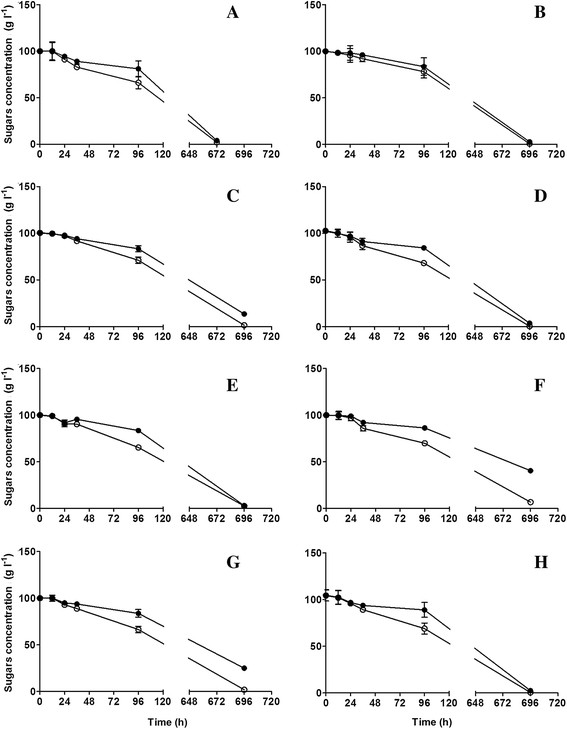
Glucose (○) and fructose (●) consumption profiles compared for the 8 yeast strains QA23 (A), VL1 (B), CEG (C), BRL97 (D), XL (E), T73 (F), NT116 (G) and UCD522 (H) in the media supplemented with low nitrogen (67 mg l
−1
).